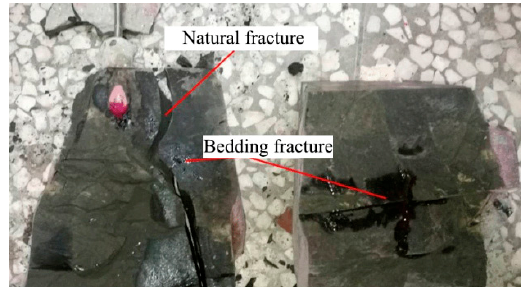
Figure 14. The observed fracture morphology for β B = 60 ◦